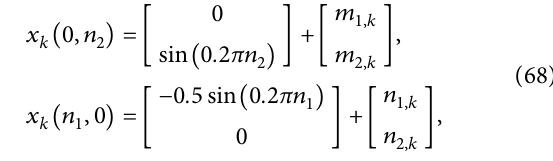
Figure 2: Under the ILC law (38), the profile of tracking error index MATE